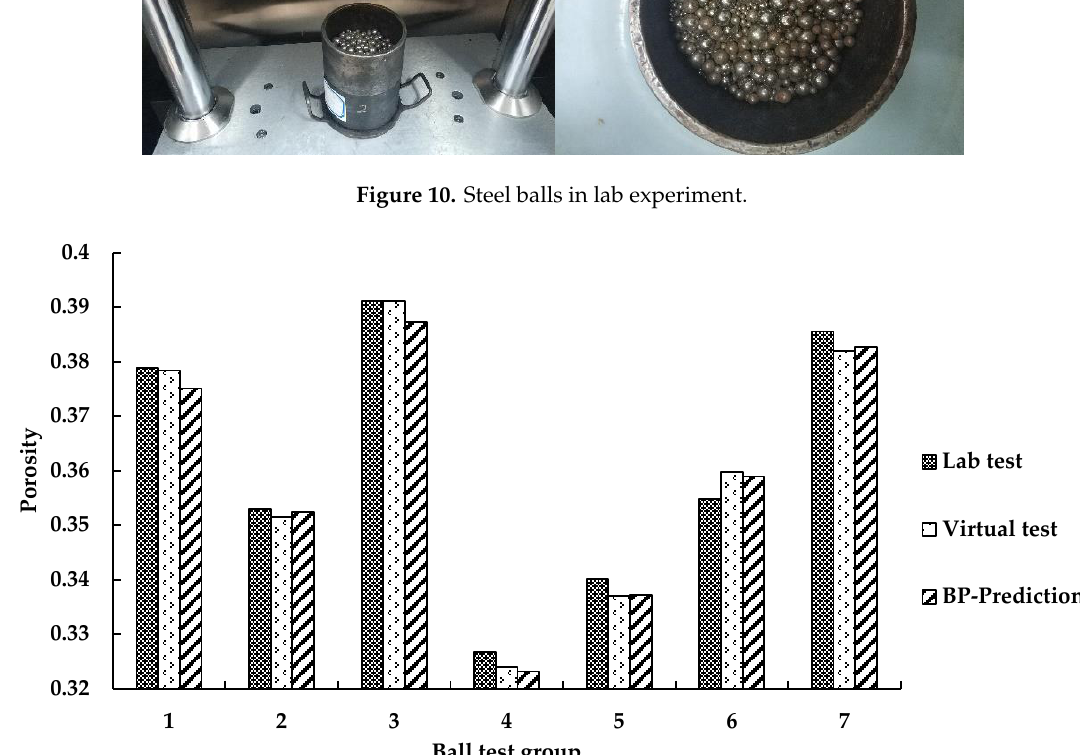
Figure 11. Porosity comparison among lab test, virtual test and BP neural network model for steel ball test.